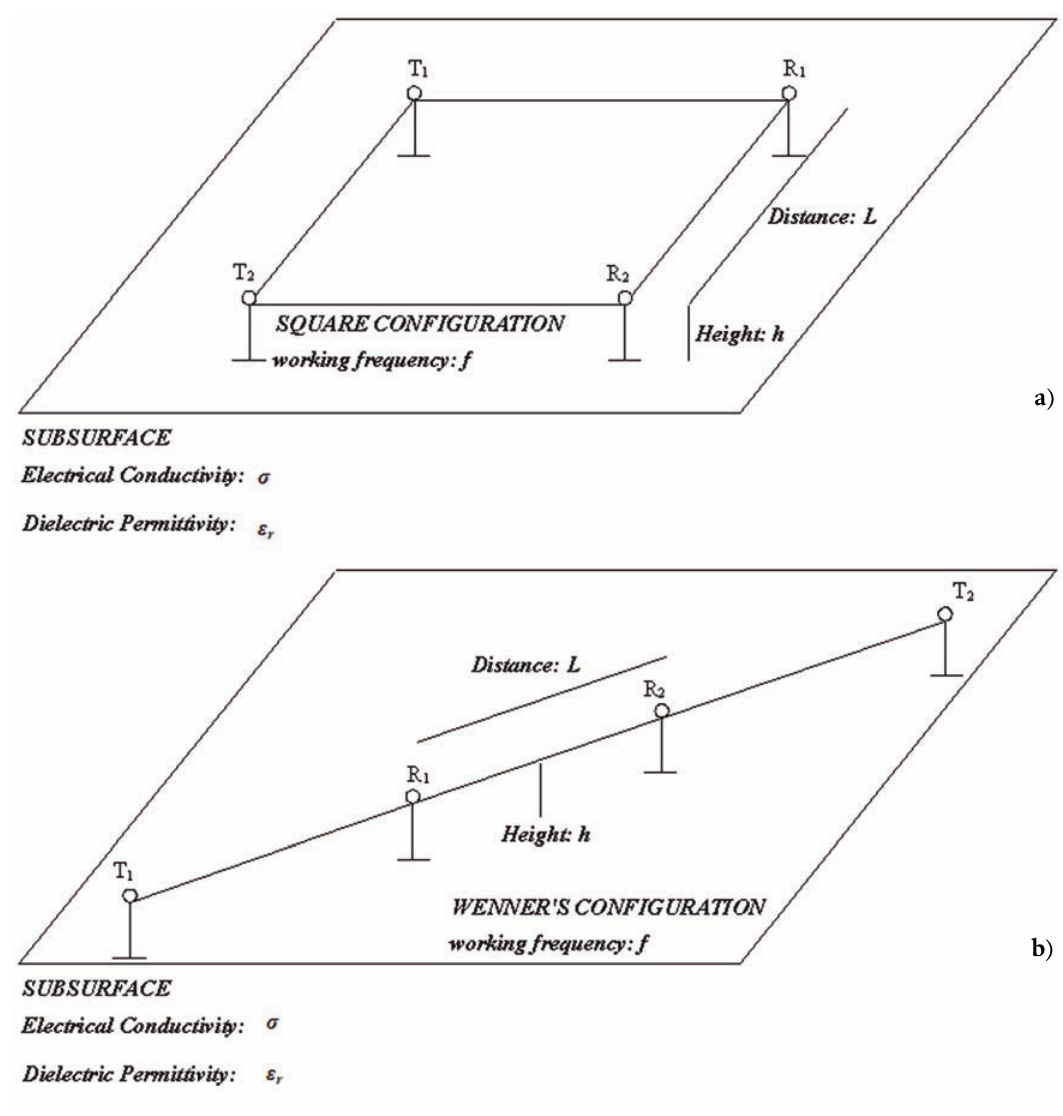
Figure 6. Quadrupolar probe in square (a) and linear (Wenner's) (b)